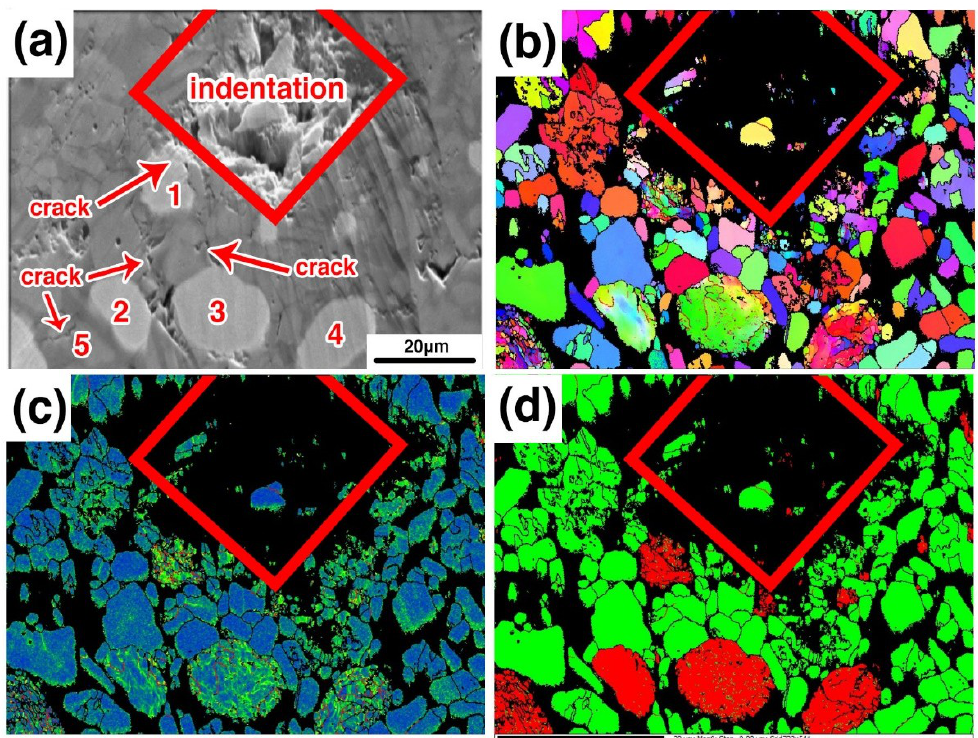
Figure 13. Crack propagation morphology of sample B3; ( a ) SEM image, ( b ) IPFX image, ( c ) stress distribution, ( d ) phase distribution.